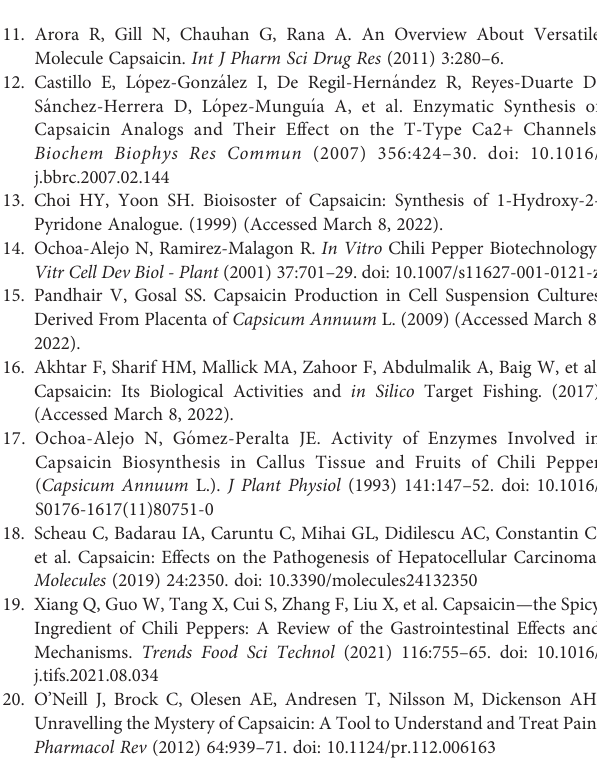
Supplementary Table 2 | Top 20 author keywords (DE) and keywords-plus (ID) associated with capsaicin articles from 2001 to 2021.